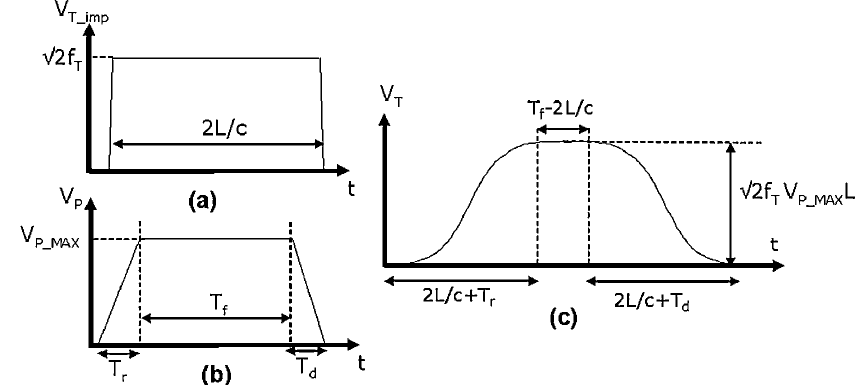
FIG. 2. (a) Ideal kicker impulse pulse response. (b) Simplified input pulse profile. (c) Total deflecting field as a function of time > 2 L=c > T assuming T f r;d